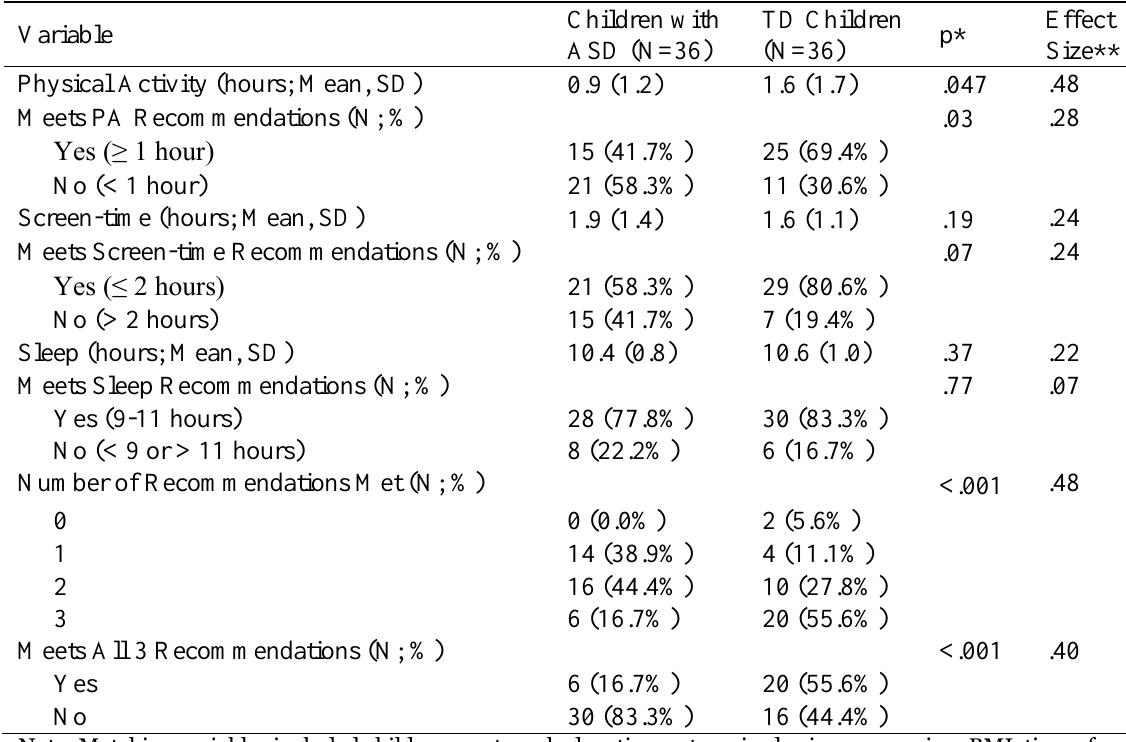
Table 1 Time in Movement Behaviours and Prevalence Rates of Meeting 24-Hour Guidelines for Children with ASD and TD Children in the Matched Sample ( N